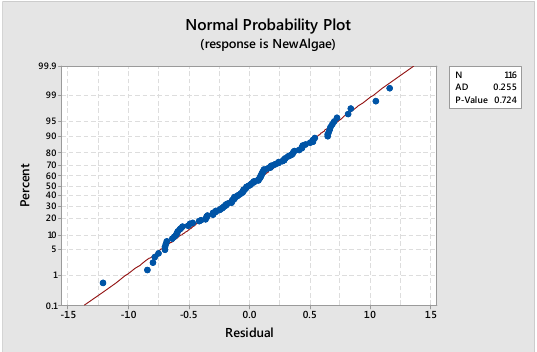
Figure 7. Normal probability plot.